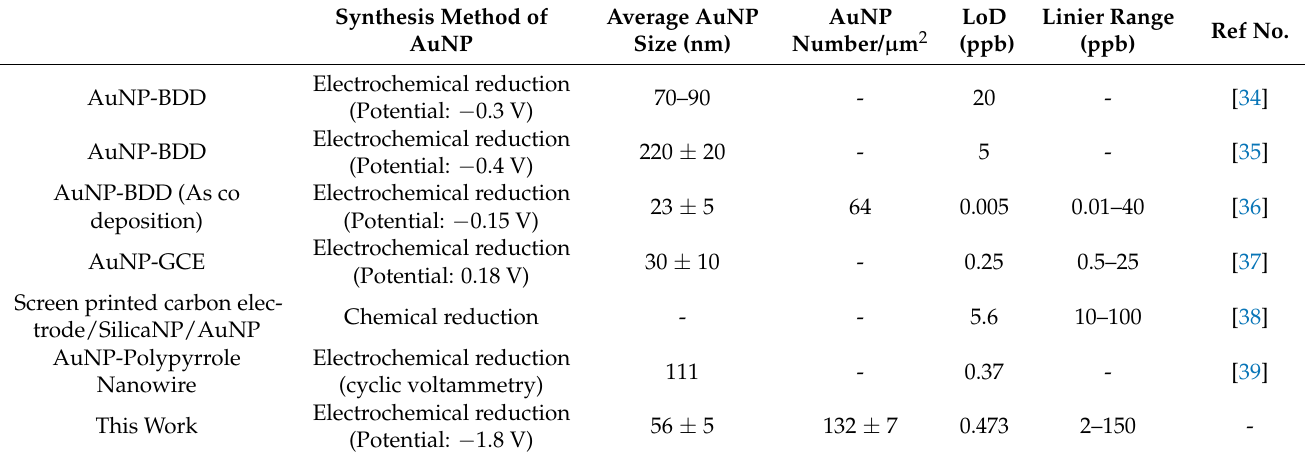
Figure 4. ( a ) Detection of As(III) in solutions with 1 to 150 ppb of As(III) using the SWASV method. ( b ) Calibration curve prepared by plotting the peak currents of As(III) detection. Error bars denote the standard deviation ( n = 3). ( c ) Detecting 10 ppb of As(III) in solutions containing 100 ppb of other heavy metal ions (Pb, Cu, and Fe). ( d ) Energy-dispersive X-ray spectral results for the electrodeposited state of the AuNP-BDD electrode fabricated at − 1.8 V for 60 s immersed in a solution with 100 ppb As(III). Yellow crosses indicate the measurement points. Table 1. Comparation with previously reported As(III) detection using AuNP modified Electrode.